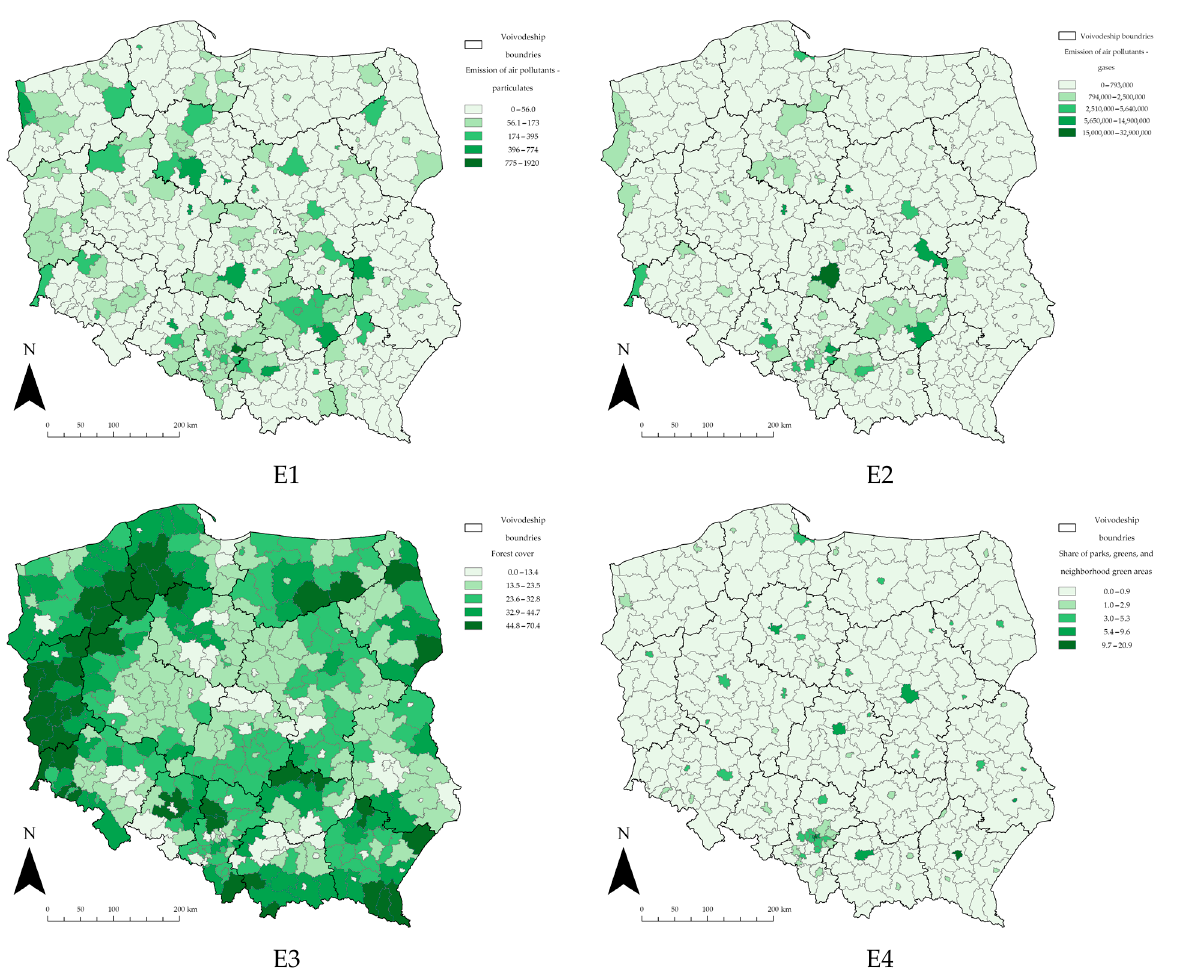
Figure 3. Spatial distribution of the explanatory variables in counties of Poland. Source: own elaboration using ArcGIS Pro 2.9 by Esri.